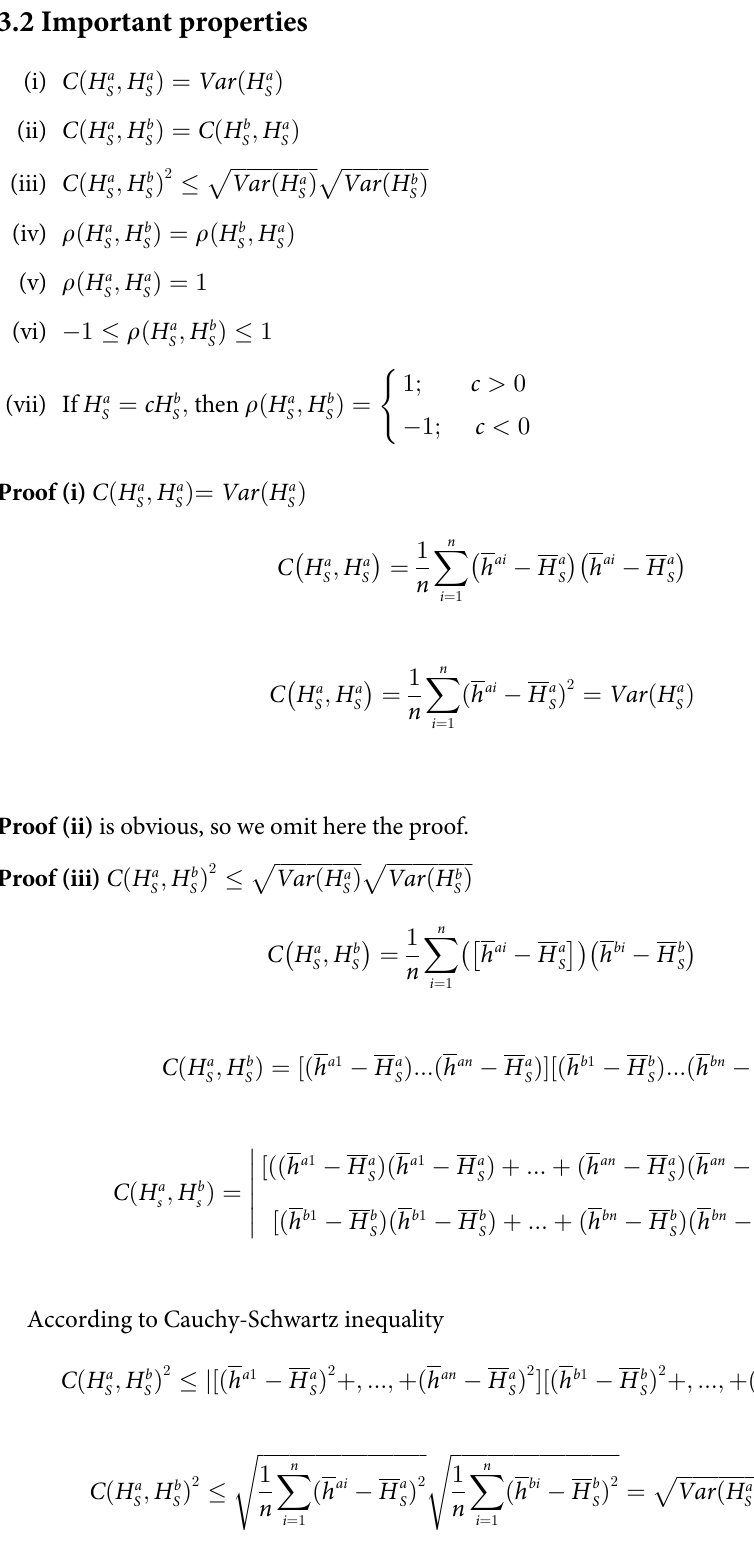
p Þ Var ð H b S